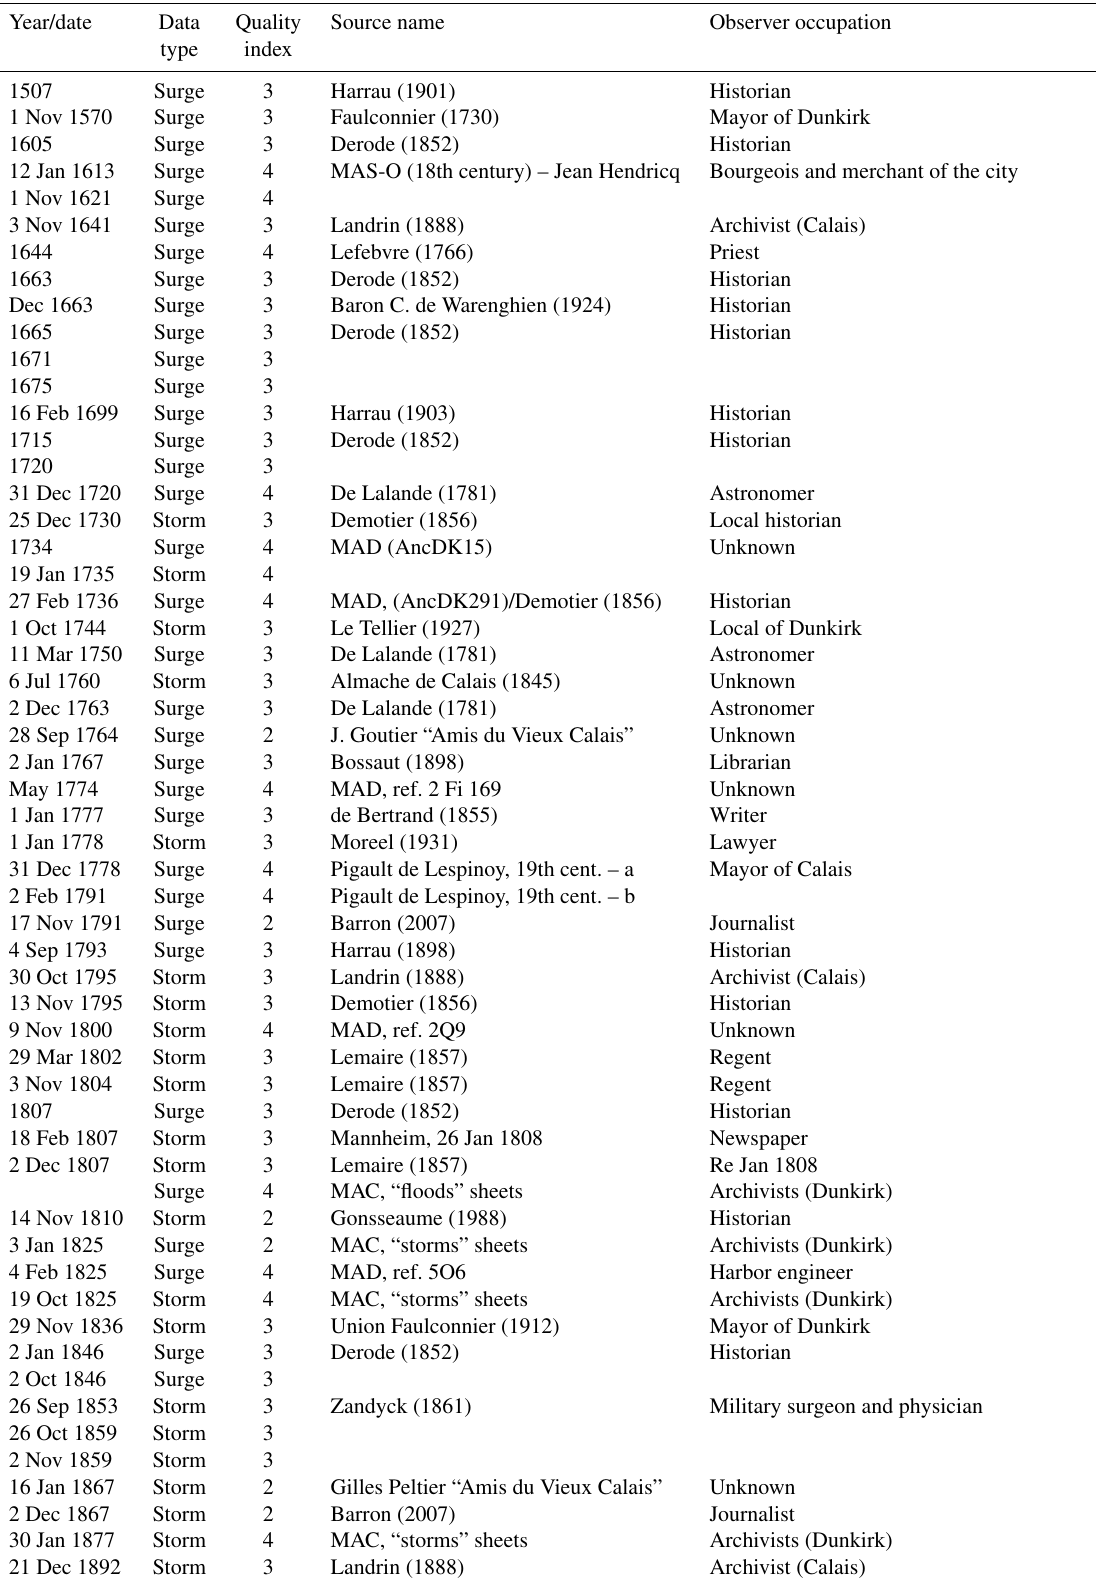
Table 2. Details of 1500–2015 Nord-Pas-de-Calais historical storms and storm surges